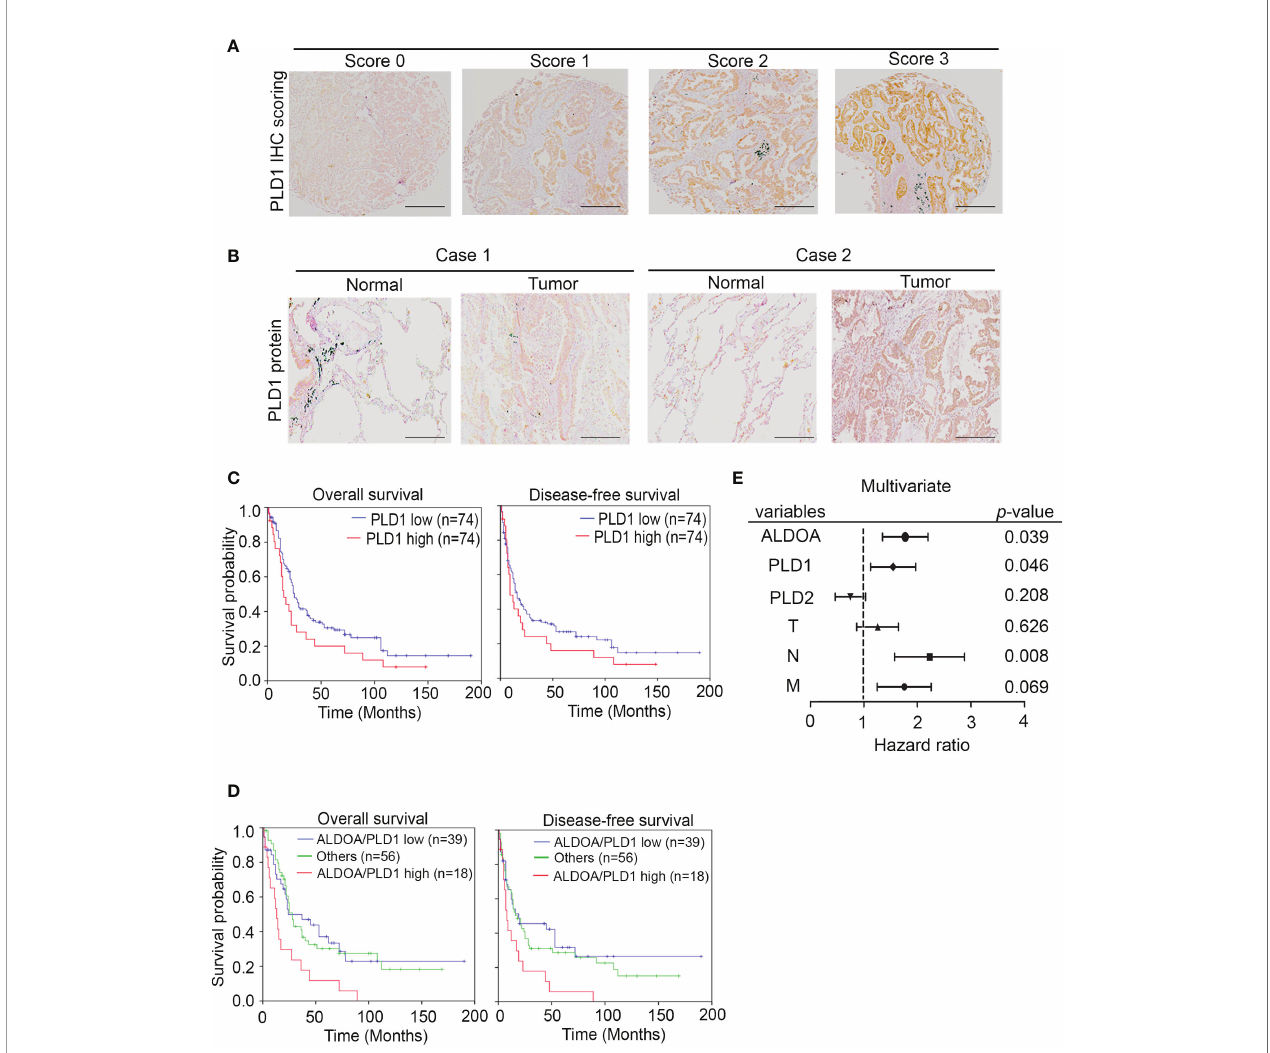
FIGURE 7 | The prognosis value of ALDOA-PLD1 for lung cancer patients. (A) Scores (0 – 3) indicate PLD1 protein levels in representative lung tumor tissues. (B) The expression level of the PLD1 protein in tumor tissue compared with the corresponding normal adjacent tissue. (C) Kaplan – Meier analysis of PLD1 protein expression at concurrently low or high levels as determined by IHC staining at the endpoint of overall survival probability and disease-free survival probability in lung cancer patients. (D) Kaplan – Meier analysis of PLD1 combined with ALDOA protein expression at concurrently low or high levels or others as determined by IHC staining at the endpoint of overall survival probability in lung cancer patients. (E) Multivariate analysis of ALDOA/PLD1/PLD2 and clinical parameters in a clinical cohort. The signi fi cance of the differences in (C, D) was analyzed using the Student ’ s t-